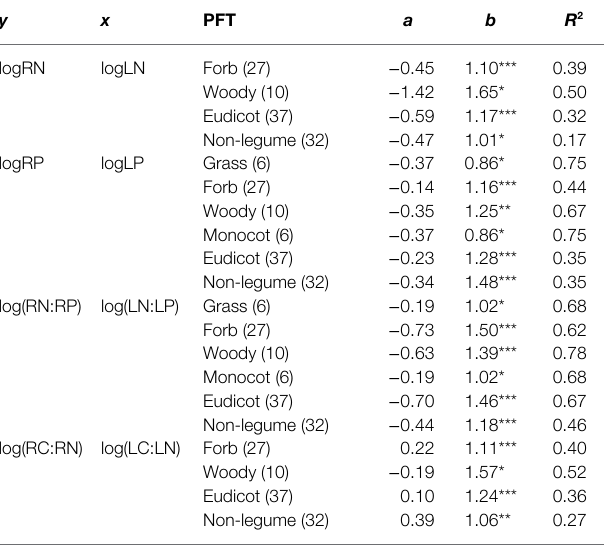
For abbreviations see Table 1 . Symbols a and b represent the intercept and slope of linear regression, respectively, R 2 represents the coefficient of determination. Only significant relationships are shown. Species numbers are included in parentheses.*Indicates significant linear regression at 0.05 confidence levels. **Indicates significant linear regression at 0.01 confidence levels. ***Indicates significant linear regression at 0.001 confidence levels.